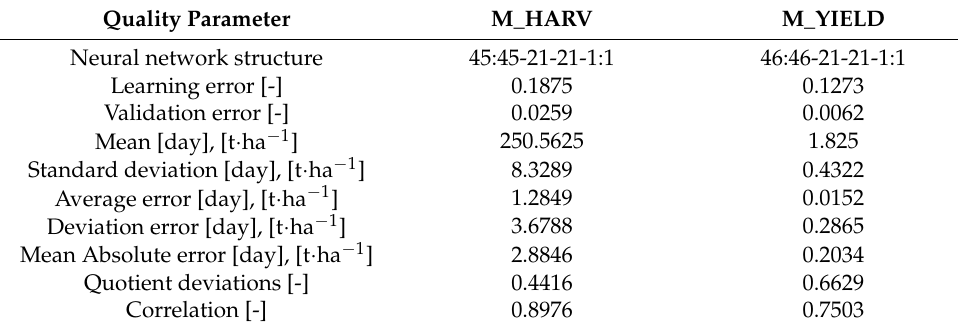
Table 4. The quality and structure of the neural models